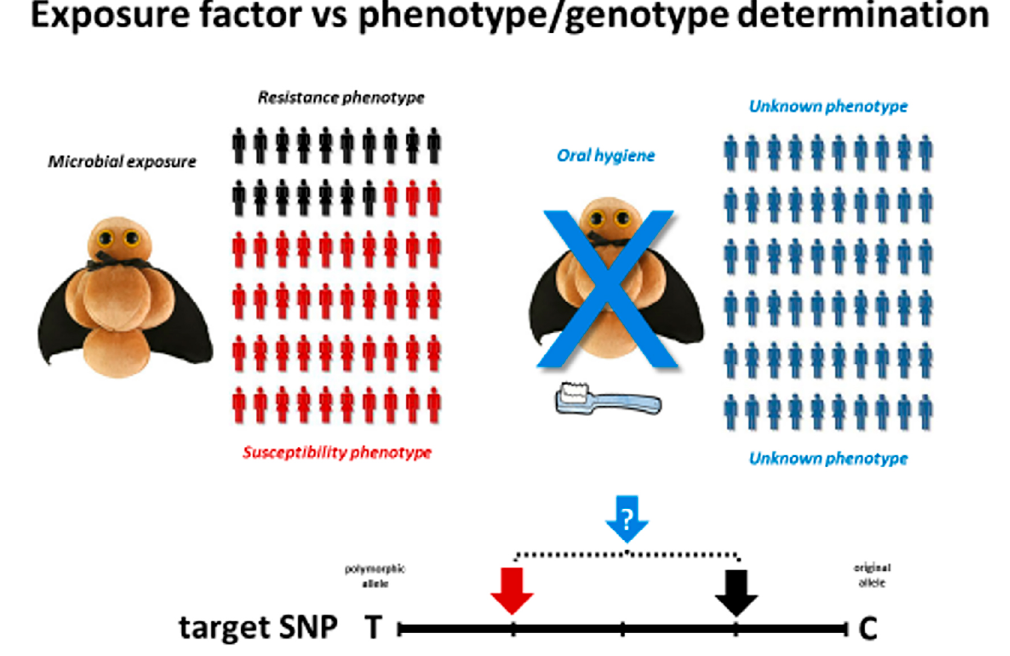
Figure 1- Exposure factor vs phenotype/genotype